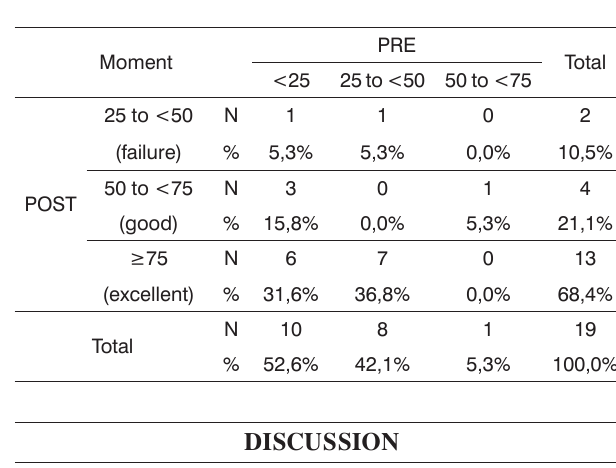
Figure 1. Pre and postoperative satisfaction score mean values from the patients submitted to rhinoplasty to correct a crooked nose (Mean ± 1SD). t-paired test p 0.0001. Table 2. Absolute and relative frequency of the patients sub- mitted to rhinoplasty to correct a crooked nose according to their satisfaction rate in the pre (PRE) and postoperative (POST) times.